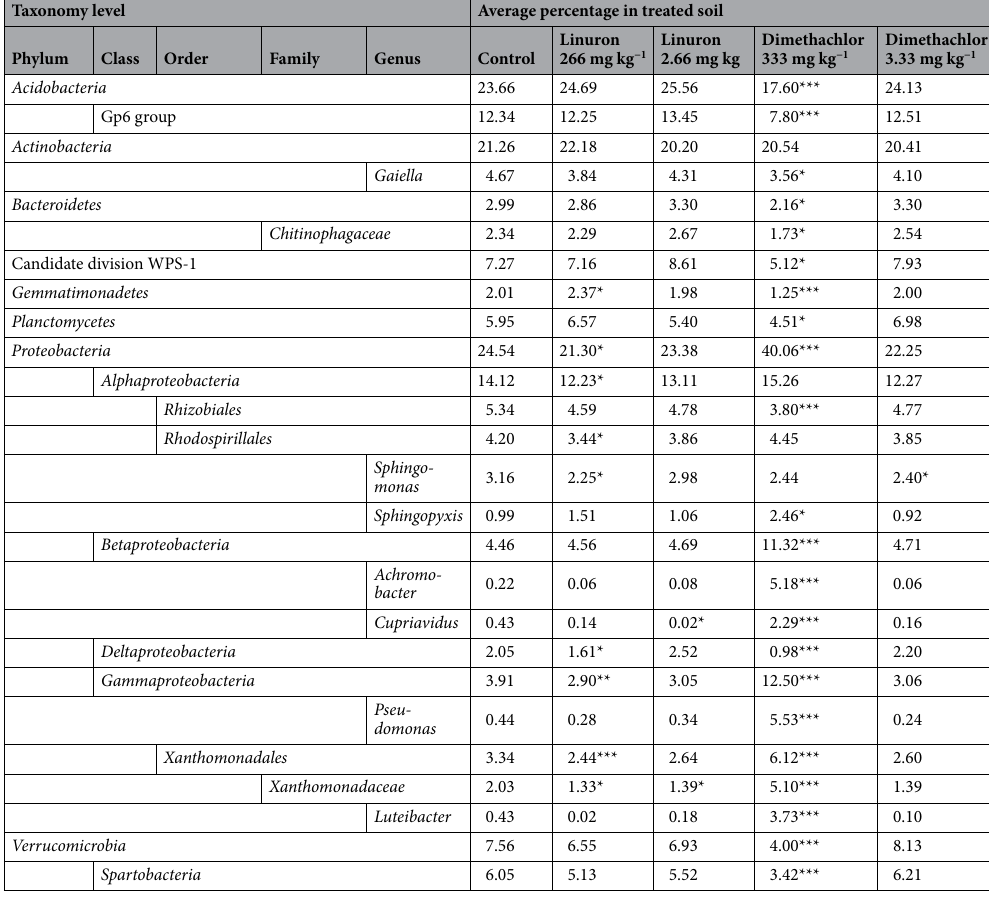
Table 1. Bacterial taxa with different abundance in soil samples treated by herbicides linuron and dimethachlor. Only groups with abundance higher than 2% in any treatment are shown. Differently abundant groups are marked (Wilcox sum-rank test, *P < 0.05, **P < 0.01, ***P <